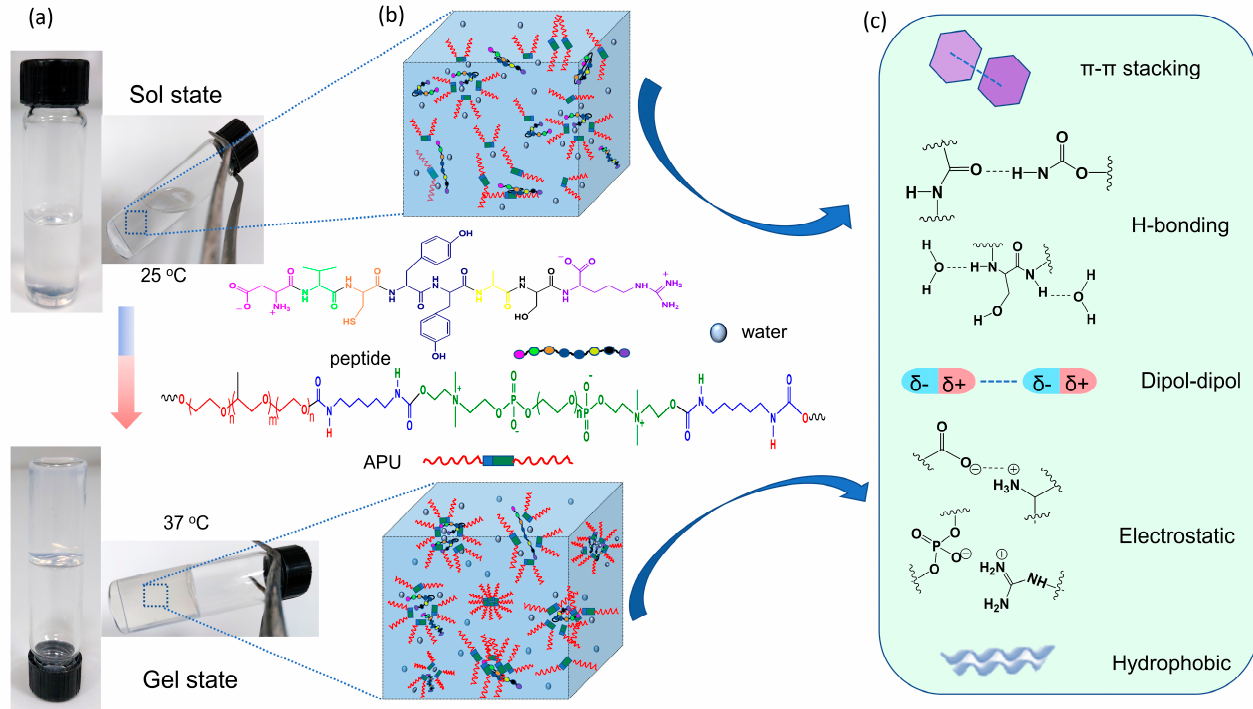
Figure 2. Illustration of self-assembly behavior of polyurethane/peptide-based gel: ( a ) Optical images of tub inverted test containing samples at 25 °C and 37 °C; ( b ) Self-assembling representation in sol and gel states; ( c ) Some physical inter- and intramolecular interactions during gel formation.